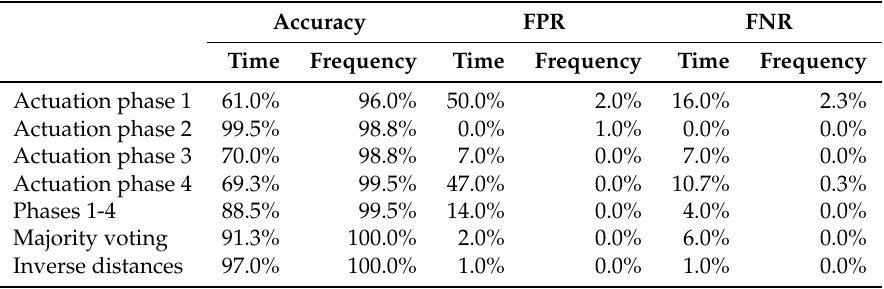
Table 9. Overall accuracy, false positive rate (FPR) and false negative rate (FNR) of the application of the t -SNE-based damage detection and classification procedure presented in Sections 3 and 4 to the case of the aluminum plate in Scenario 3 , when the four actuation phases are used separately and at the same time, in both domains, time and